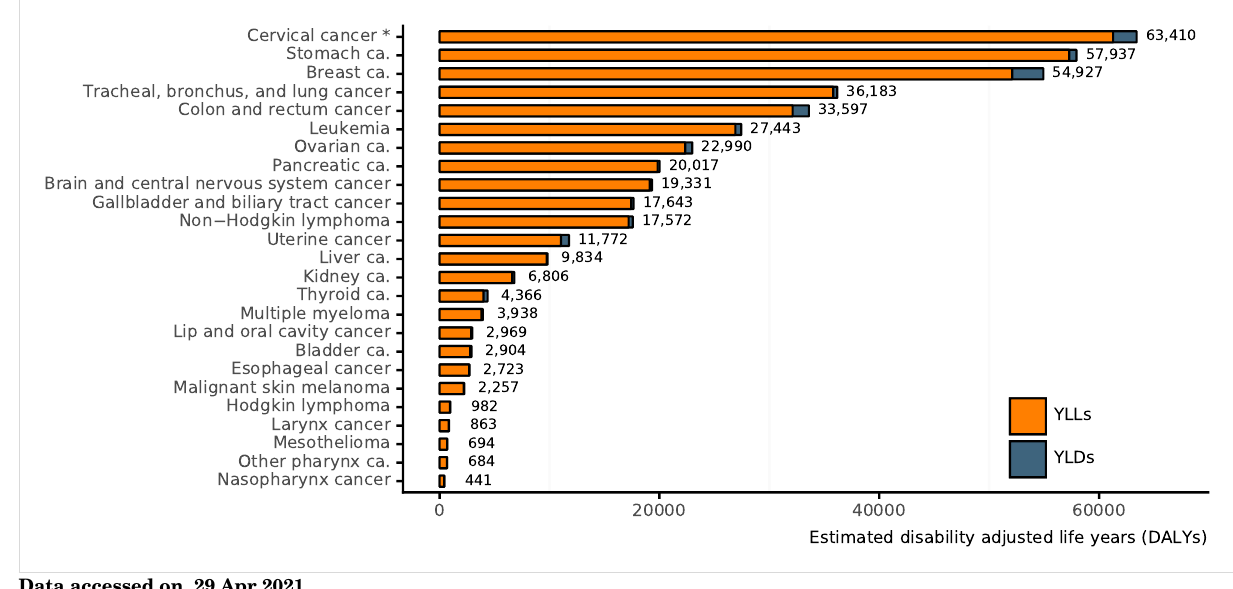
Figure 14: Comparison of annual premature deaths and disability from cervical cancer in Peru to other cancers among women (estimates for